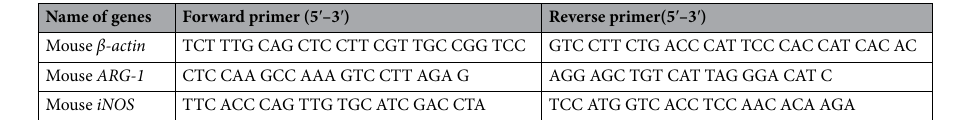
Table 1. Forward and reverse primers used for